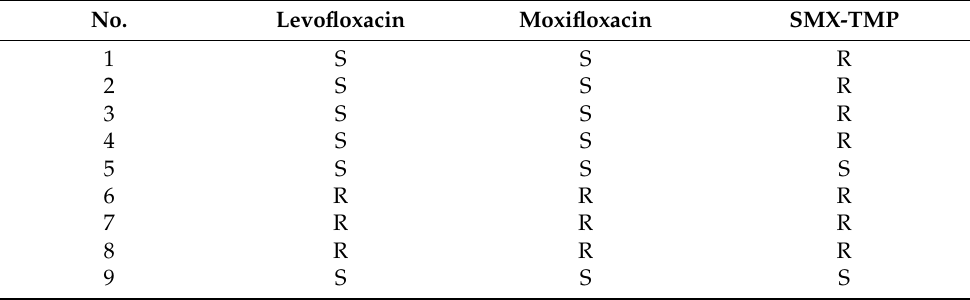
Table 2. Antibiotic susceptibility results of Stenotrophomonas maltophilia . No.